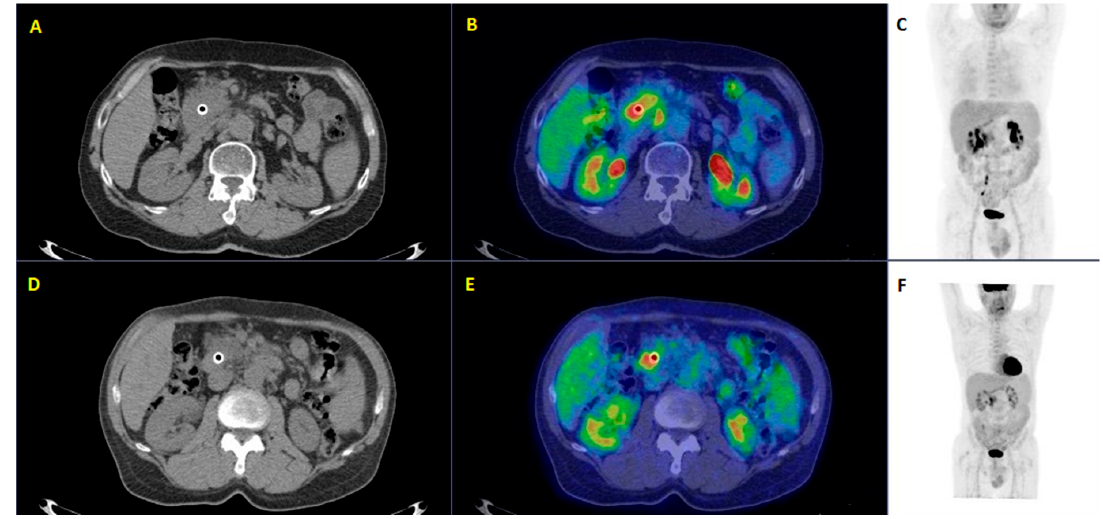
Figure 6. A fifty-four-year-old patient affected by local invasive ductal adenocarcinoma underwent restaging 18 F-FDG PET/CT before and after chemotherapy. 18 F-FDG PET/CT after 4 cycles of FOLFIRINOX ( A – C ) compared to the same examination before chemotherapy ( D – F ) revealed increasing metabolic activity of the pancreatic lesion (SUVmax = 14 vs. 10) and the appearance of a new locoregional lymph-nodal uptake in the surrounding fat (SUVmax = 7), demonstrating the lack of therapy response with the subsequent modification of therapy management. (Images from Nuclear Medicine Unit, Fondazione Istituto G.Giglio of Cefalù, Italy). Legend: A = Axial image of low-dose CT after chemotherapy; B = PET/CT fused image after chemotherapy; C = Maximum intensity Projection (MIP) after chemotherapy; D = Axial image of low-dose CT before chemotherapy; E = PET/CT fused image before chemotherapy; F = Maximum intensity Projection (MIP) before chemotherapy.